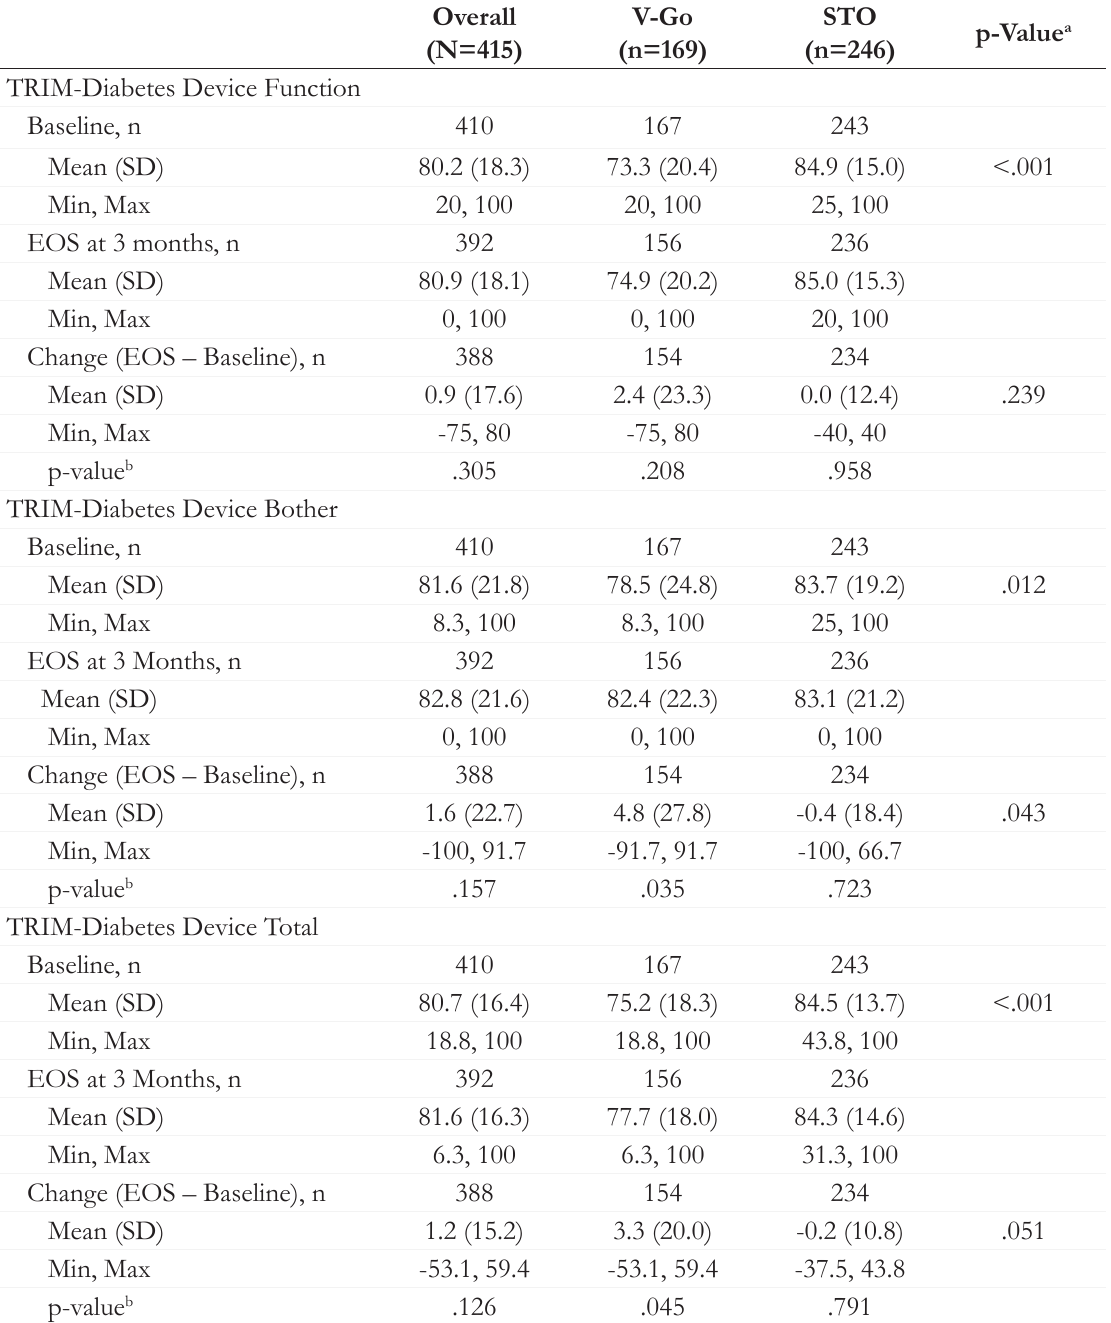
Overall V-Go (N=415) (n=169)